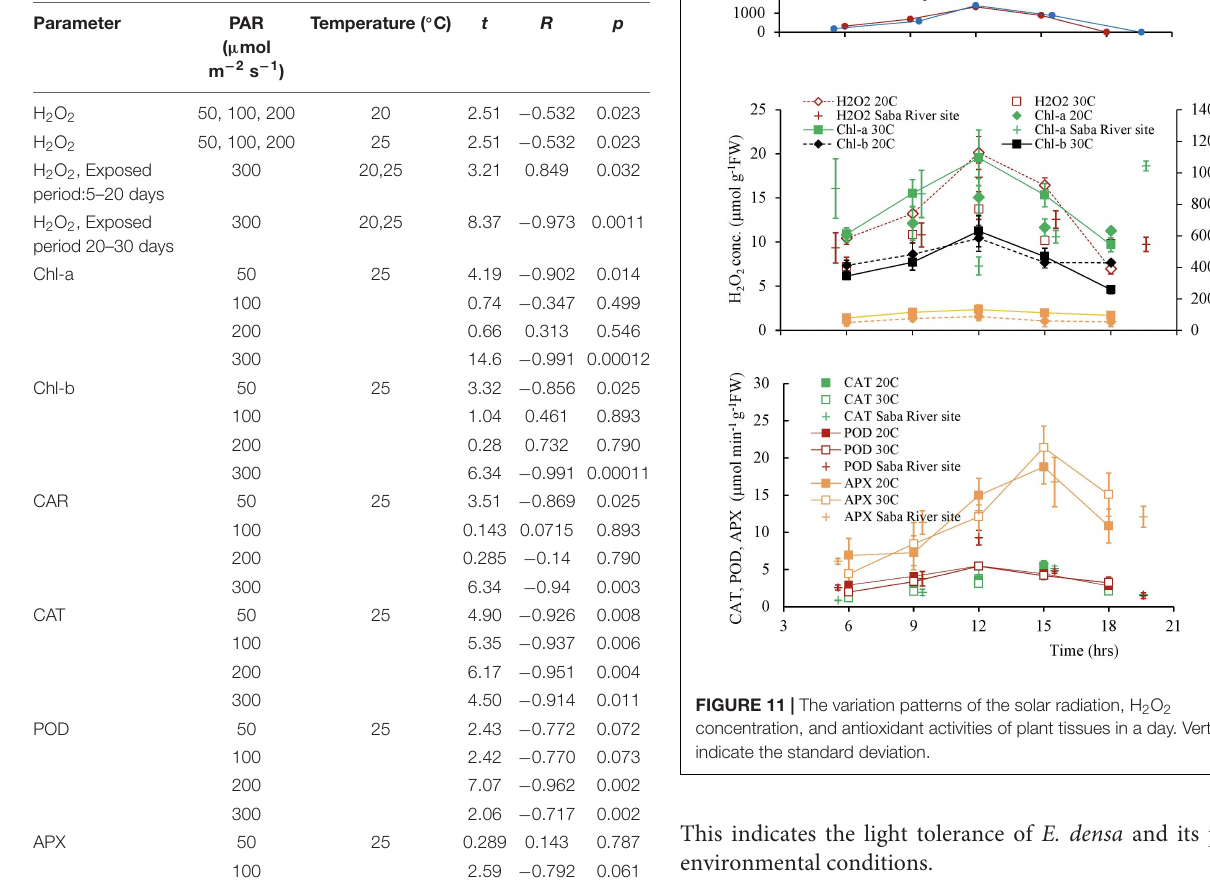
TABLE 4 | Relationship between parameters and the exposed period in 30 days experiment.